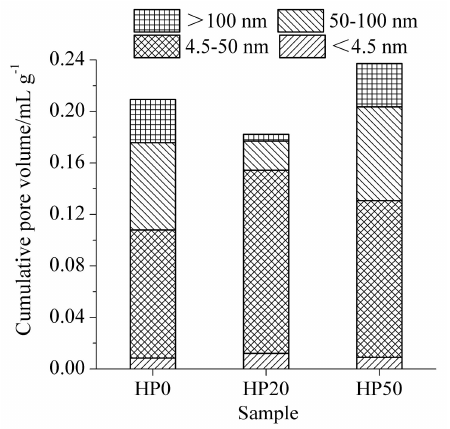
Figure 5. Pore structure of cement-ITP hardened paste cured for 3 days at 60 ◦